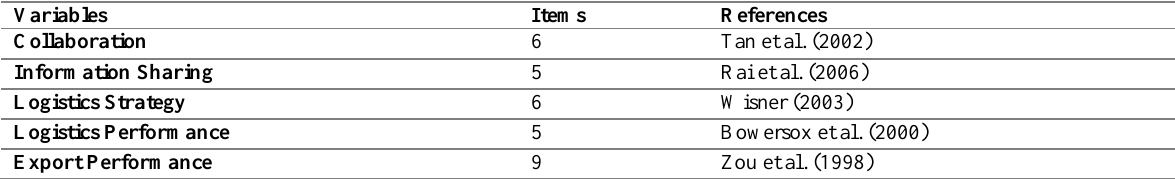
Table 1: List of variables and number of research